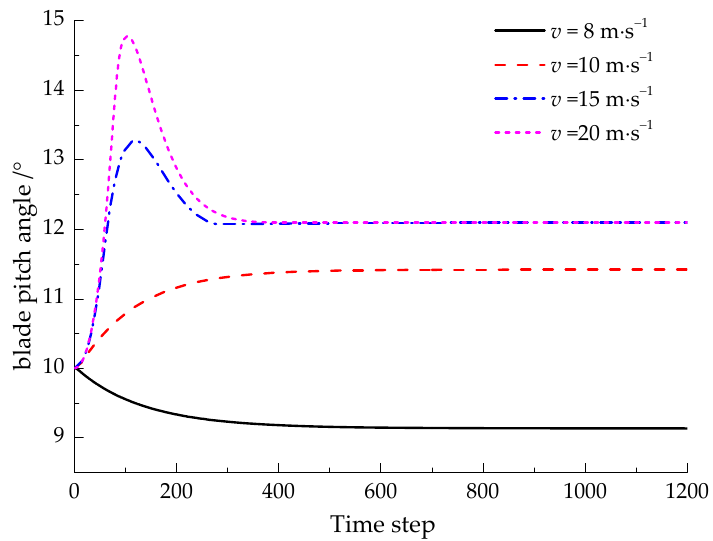
Figure 9. Variation of the rotor speed in terms of the time step for various wind speeds.